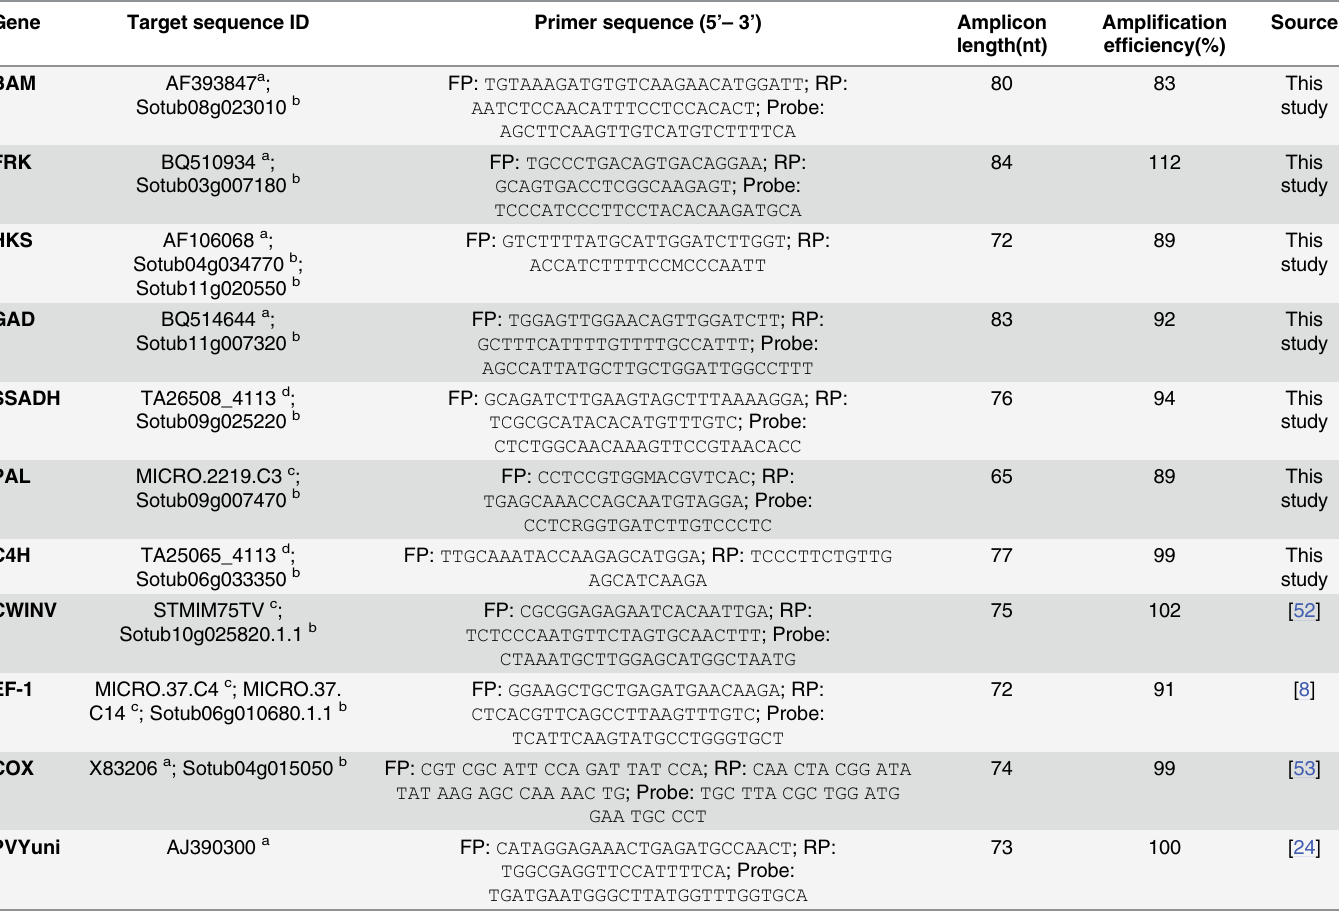
Table 3. Target sequences, forward (FP) and reverse (RP) primers, and probe sequences (Probe) of amplicons for the genes investigated. Gene Target sequence